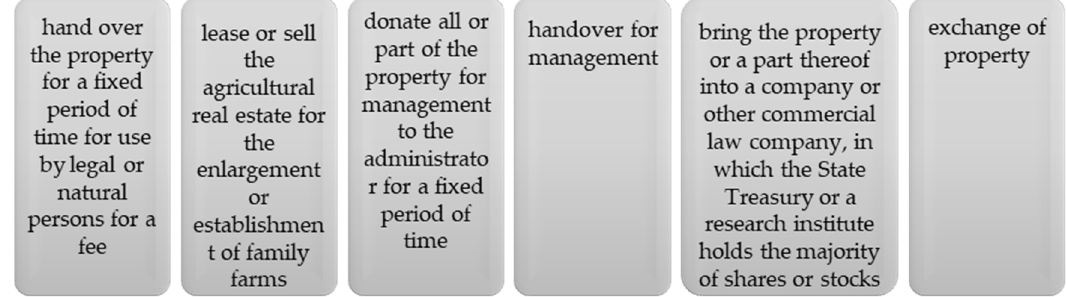
Figure 1. The state has authorized the National Agricultural Support Centre (NASC) to perform the tasks; source: [29].